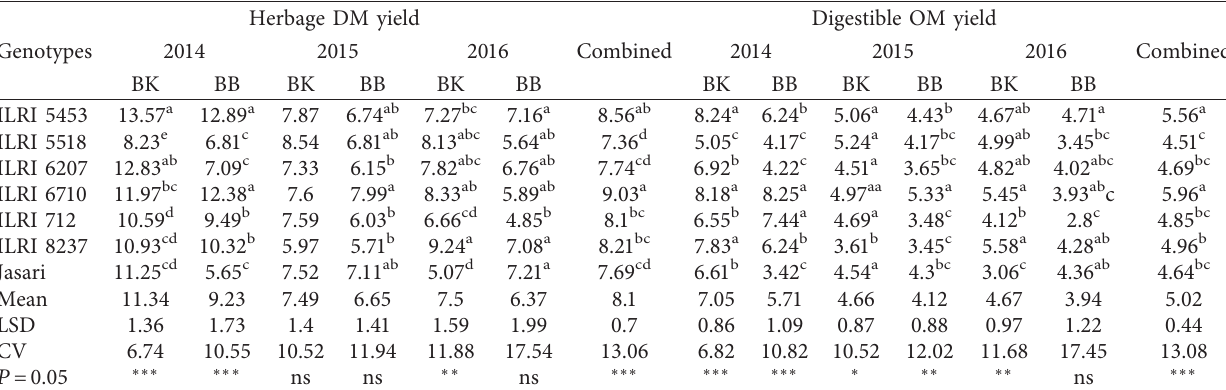
Table 2: Herbage dry matter (DM) and digestible organic matter (OM) yield mean values of the seven oat genotypes tested at each location over the three years (2014, 2015, and 2016).